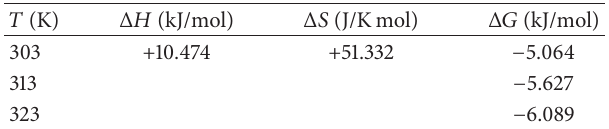
endothermic process. Positive value of Δ𝑆 (+51.332 J/K mol) reflects the randomness at solid solution